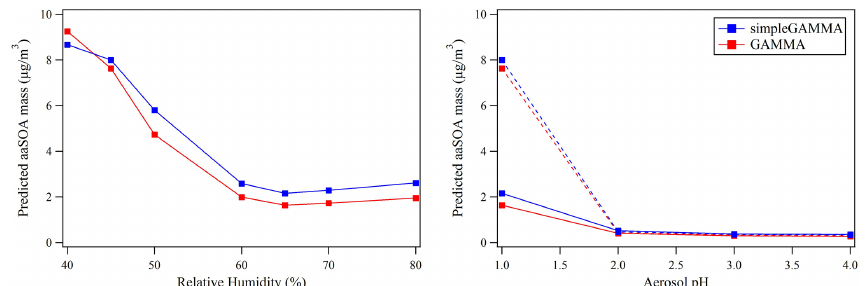
Figure 2. Comparison of predicted aaSOA after 12h of simulated time with respect to RH at pH1 (left) and with respect to pH at 45% and 65% RH (right, dotted and solid lines respectively), low-NO x conditions.